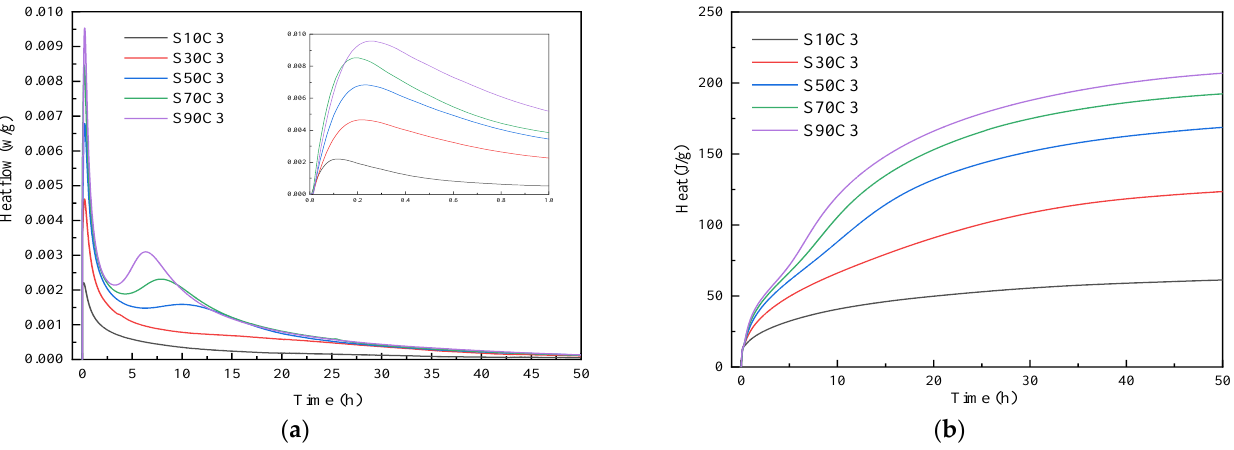
Figure 3. Comparison of the reaction heats of alkali-activated composite cementitious materials under different slag contents: ( a ) exothermic reaction rate; ( b ) total heat release.